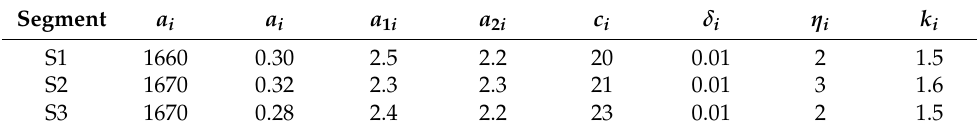
Table 1. Parameters used in numerical examples.